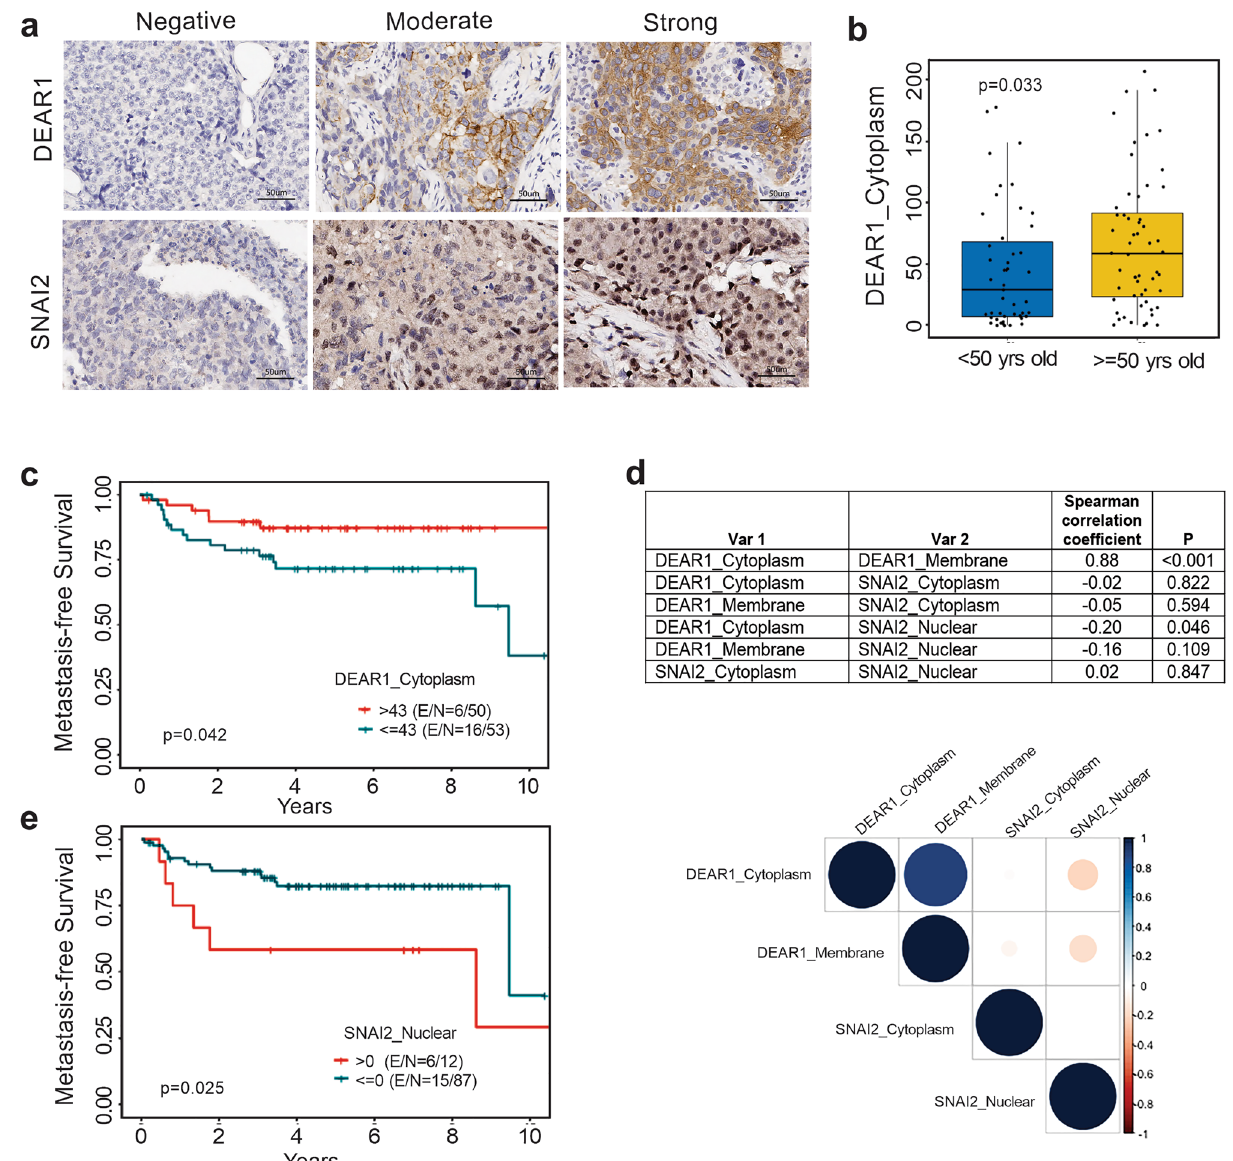
Figure 5. DEAR1 and SNAI2 expression analysis in a TNBC TMA cohort. ( a ). Representative images of DEAR1 and SNAI2 IHC in TNBC TMA analysis (Scale bars equal 50 µm). ( b ) Boxplot of cytoplasmic DEAR1 expression in groups of patients under (blue) or over (yellow) the age of 50 years. ( c ) Kaplan–Meier analysis of metastasis-free survival in DEAR1 groups dichotomized by the median of cytoplasmic DEAR1 expression (High expression = red, low = blue). ( d ) Spearman’s correlations of DEAR1 and SNAI2 expression across different cellular fractions. Spearman’s correlation was performed using R Statistical Software (version 3.4.2; R Foundation for Statistical Computing, Vienna, Austria). ( e ) Kaplan–Meier analysis of metastasis-free survival in SNAI2 groups dichotomized by presence (red) or absence (teal) of nuclear SNAI2 expression. Both ( c ) and ( e ) were analyzed by the log-rank